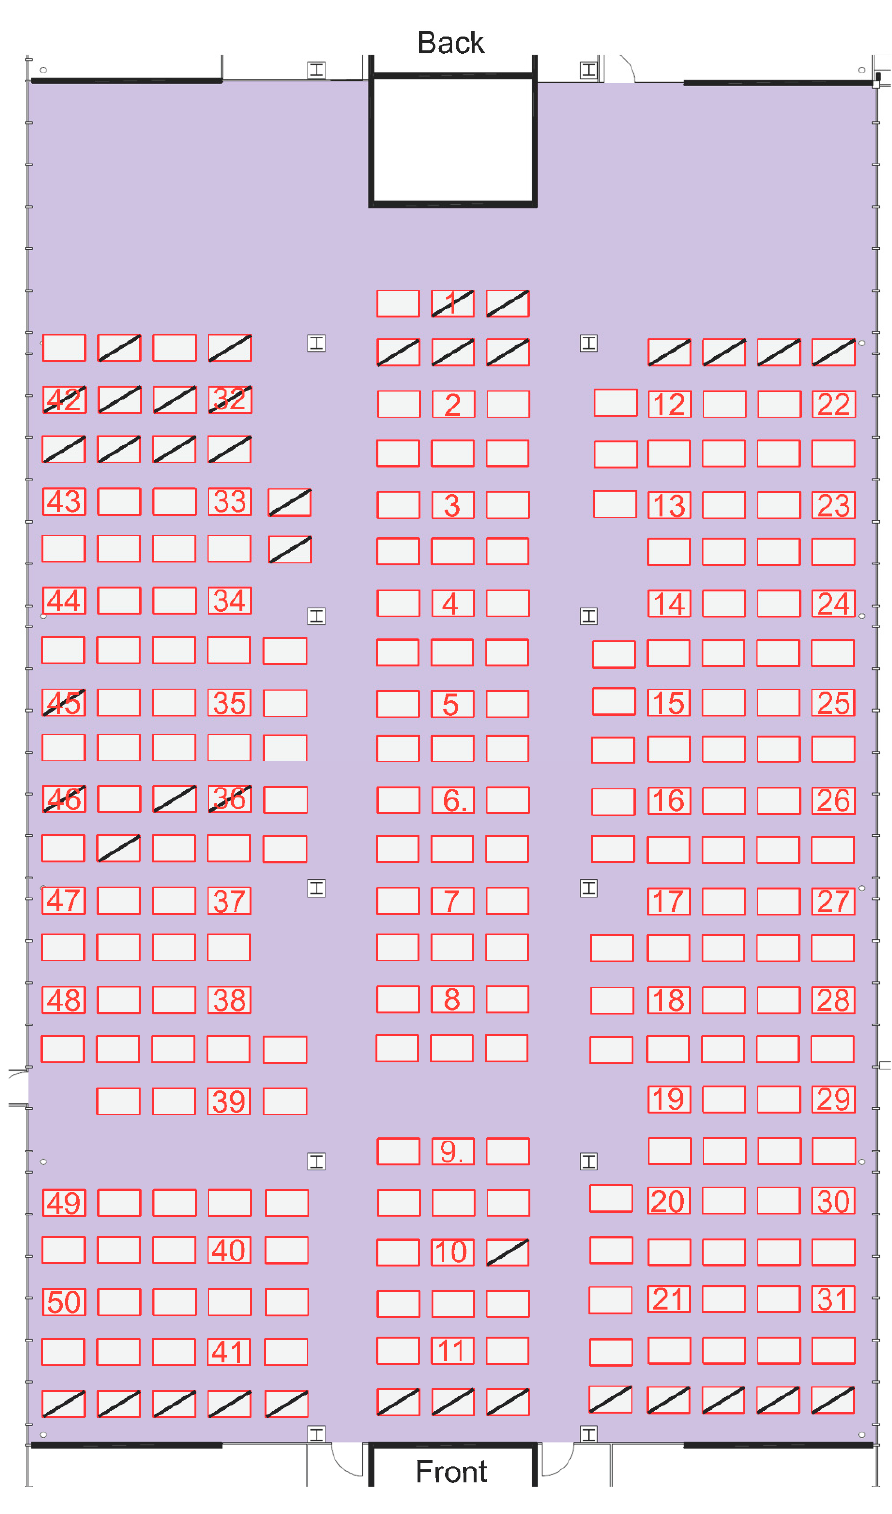
Figure 6. Layout of at-grade seminar room with measurement unit placements annotated. Unoccu- pied desks are crossed out.